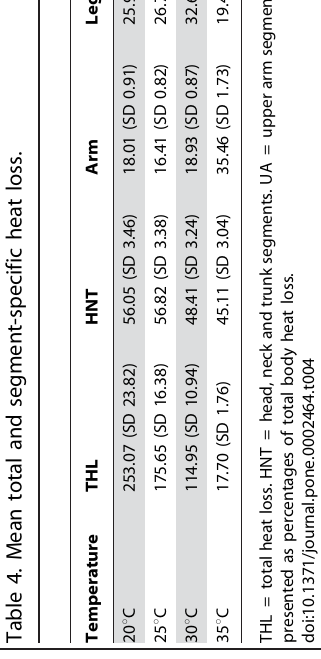
estimates for the 14 body segments (values for left and right sides